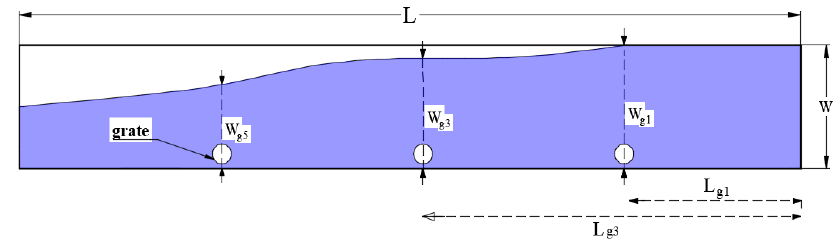
Figure 1. Plan of flume and arrangements of grates.